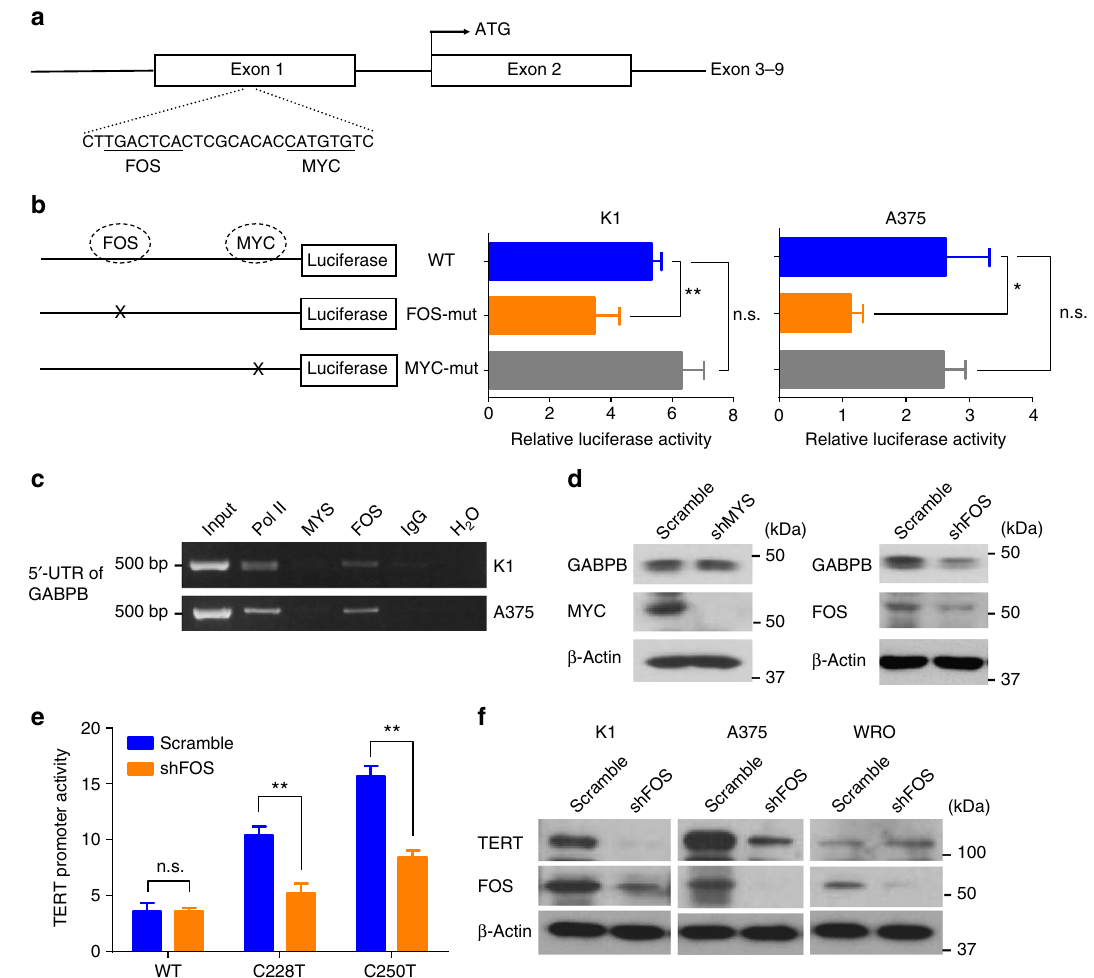
Fig. 5 FOS bound to 5 ′ -UTR of GABPB and upregulated mutant TERT expression. a Diagrammatic illustration of the putative FOS- and MYC-binding sites in the 5 ′ -UTR of GABPB identi fi ed by bioinformatics analyses. The predicted palindromic FOS consensus binding site (5 ′ -TGACTCA-3 ′ ) and the canonical MYC binding site (5 ′ -CATGTG-3 ′ ) located at +222 to +228 and +238 to +243, downstream of the transcriptional start site, respectively. b GABPB 5 ′ -UTR region-luciferase-reporter assays for the wild-type and arti fi cially-induced mutated putative FOS- and MYC-binding sites. c ChIP assay for FOS and MYC occupancy at the 5 ′ -UTR of GABPB in K1 and A375 cells. Pol II and IgG were used for positive and negative controls, respectively. d Western blotting analyses of GABPB, MYC, FOS, and beta-actin in K1 cells with stable FOS or MYC knockdown. e TERT promoter-luciferase reporter assays in K1 cells with stable FOS knockdown. f Western blotting analyses for TERT, FOS, and beta-actin in K1, A375 and WRO cells with or without stable FOS knockdown. * P < 0.05, ** P < 0.01, by two-tailed Student ’ s t test. n.s. not signi fi cant. All values represent the average ± standard deviation (SD) of triplicate samples, and similar results were obtained in three independent